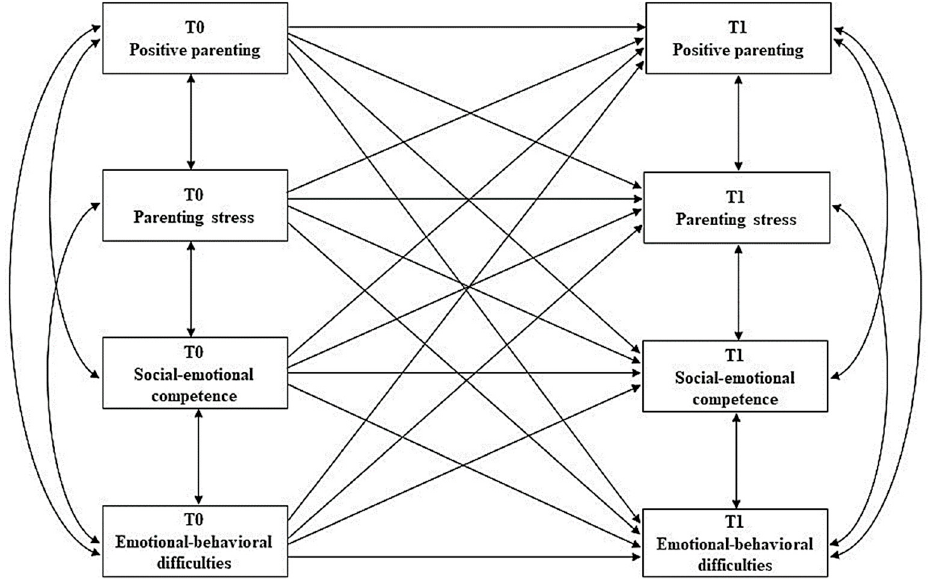
Figure 1. Hypothesized autoregressive cross-lagged model .